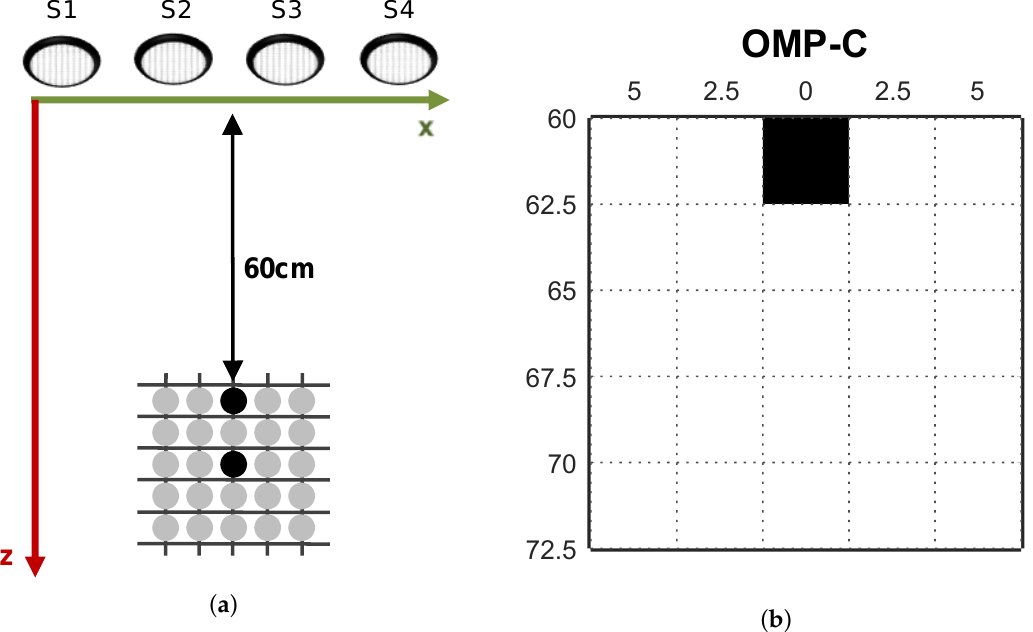
Figure 16. Image reconstruction error: an example of a missing object when two obstacles are in the same longitudinal axis. ( a ) presents the position of the obstacles with reference to the transducers, and ( b ) presents the resulting OMP-C